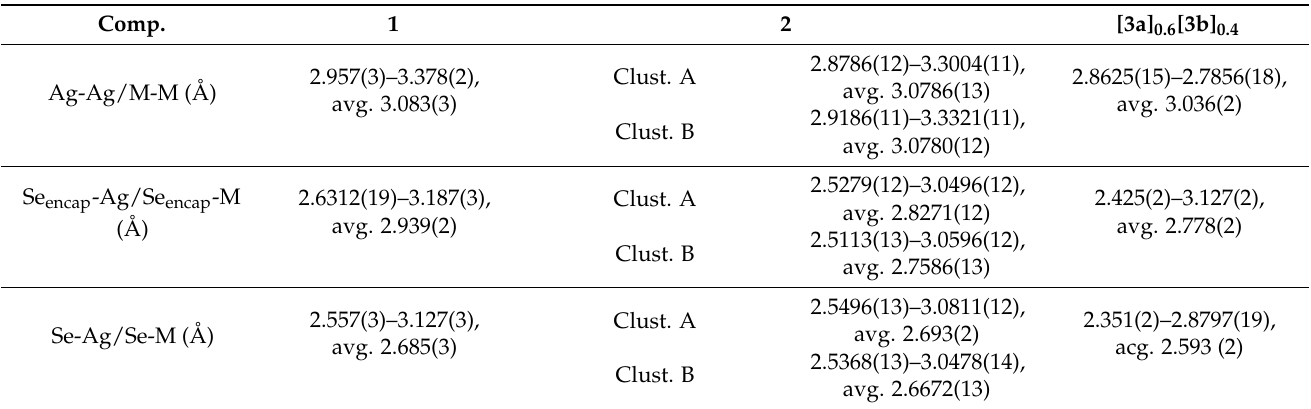
Table 1. Selected bond lengths of 1, 2 and [ 3a ] 0.6 [ 3b ] 0.4